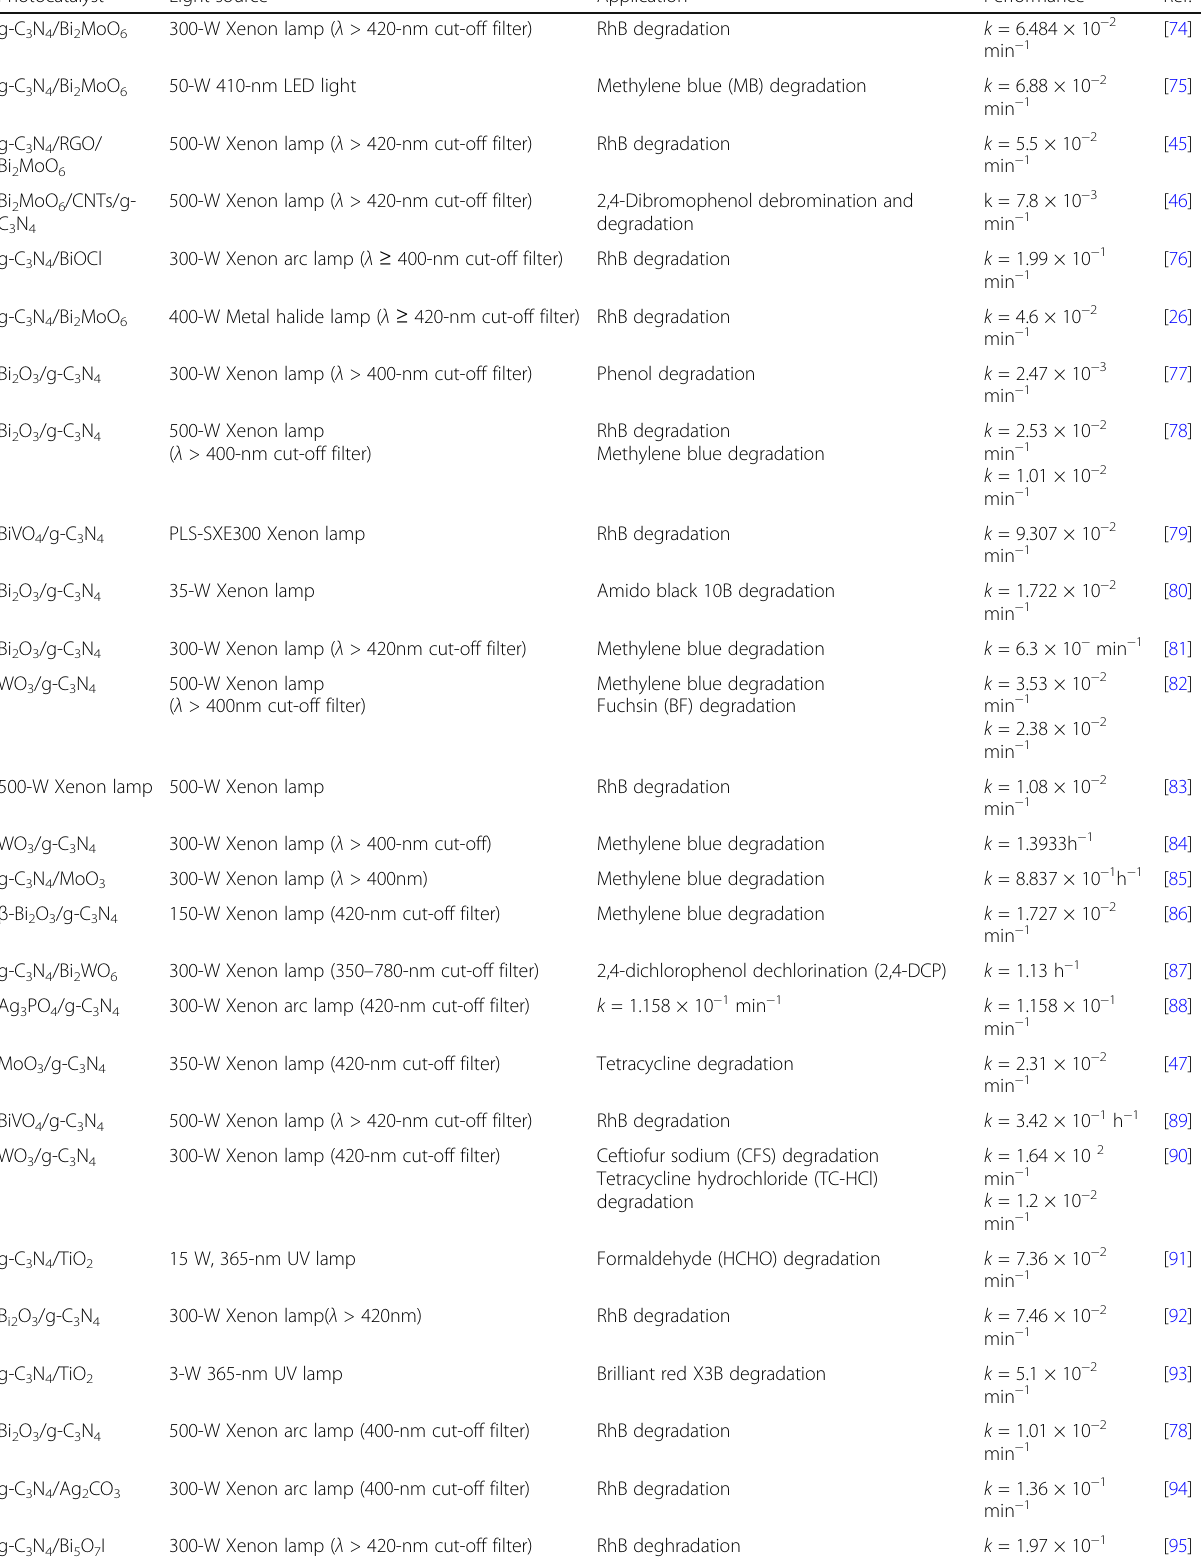
Table 1 Studies of g-C 3 N 4 heterojunctions for various pollutants degradations